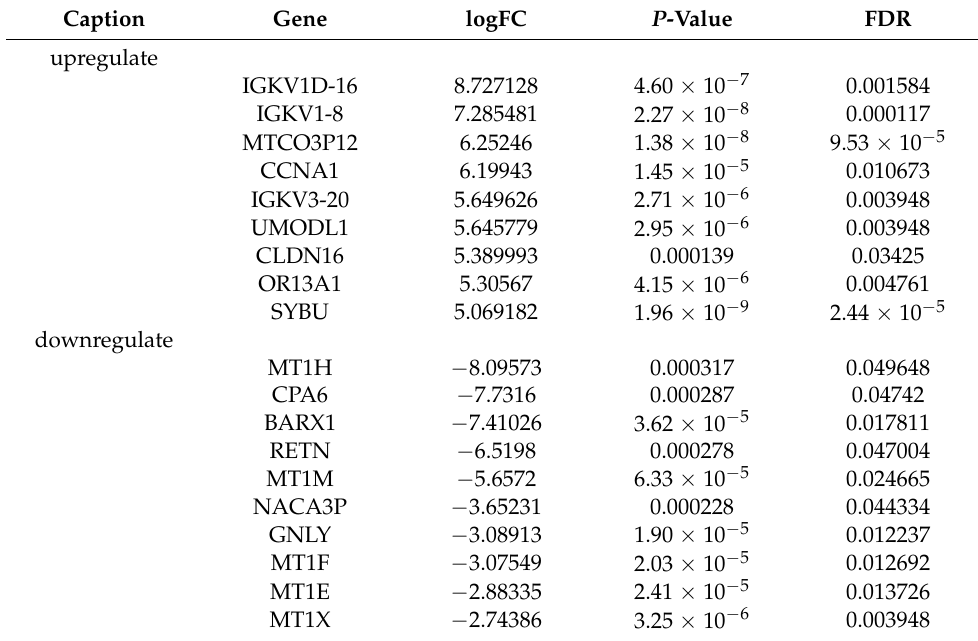
Table 6. The top 10 upregulated genes and 10 downregulated genes identified in the gene expression microarray of 10 supradiaphragm patients and 4 subdiaphragm